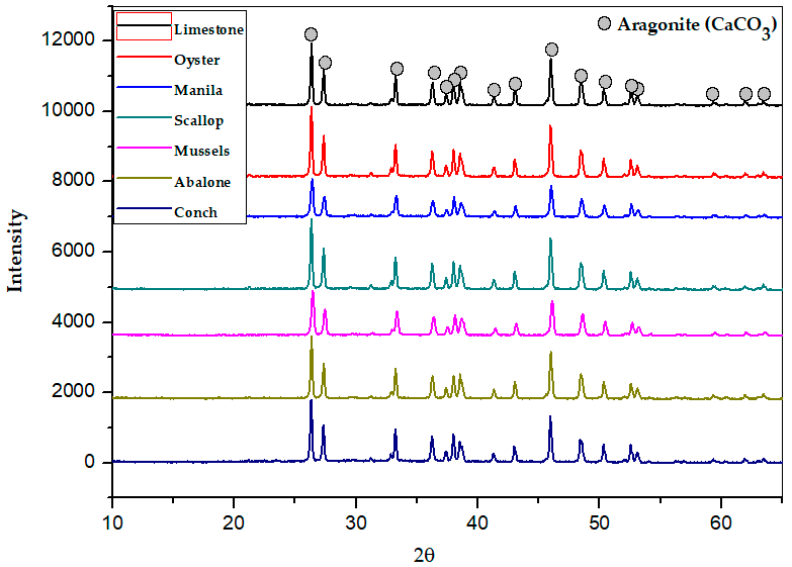
Figure 7. XRD patterns of aragonite precipitated CaCO 3 by the carbonation from different mollusk shells and limestone samples at 80 °C, 3 h duration time.